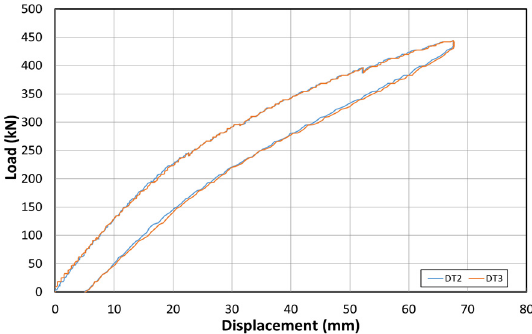
Figure 11. Load–displacement curve before reinforcement based on the EP method.